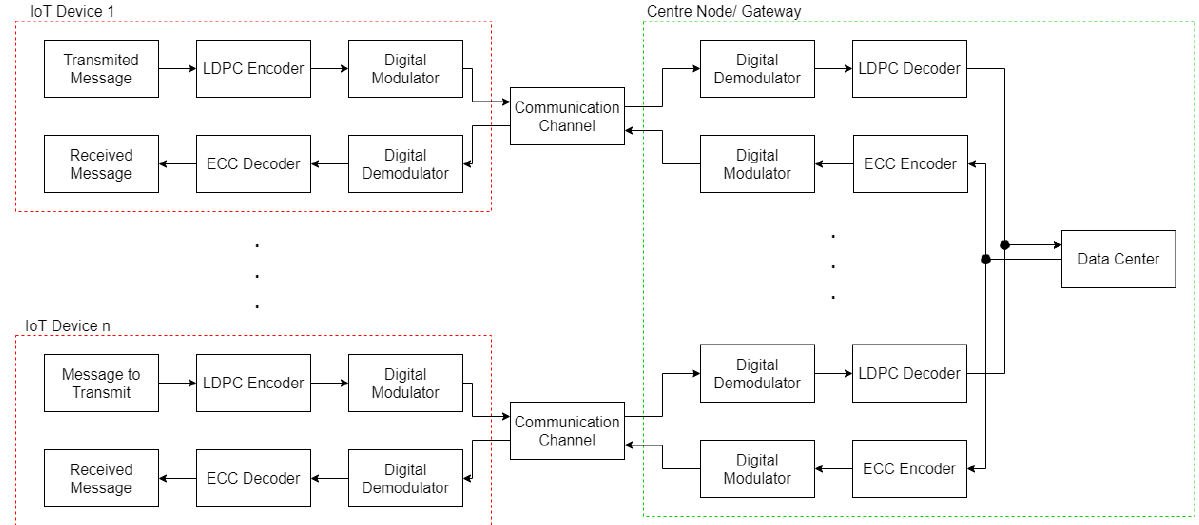
Figure 1. General architecture of IoT communication using LDPC codes for the error